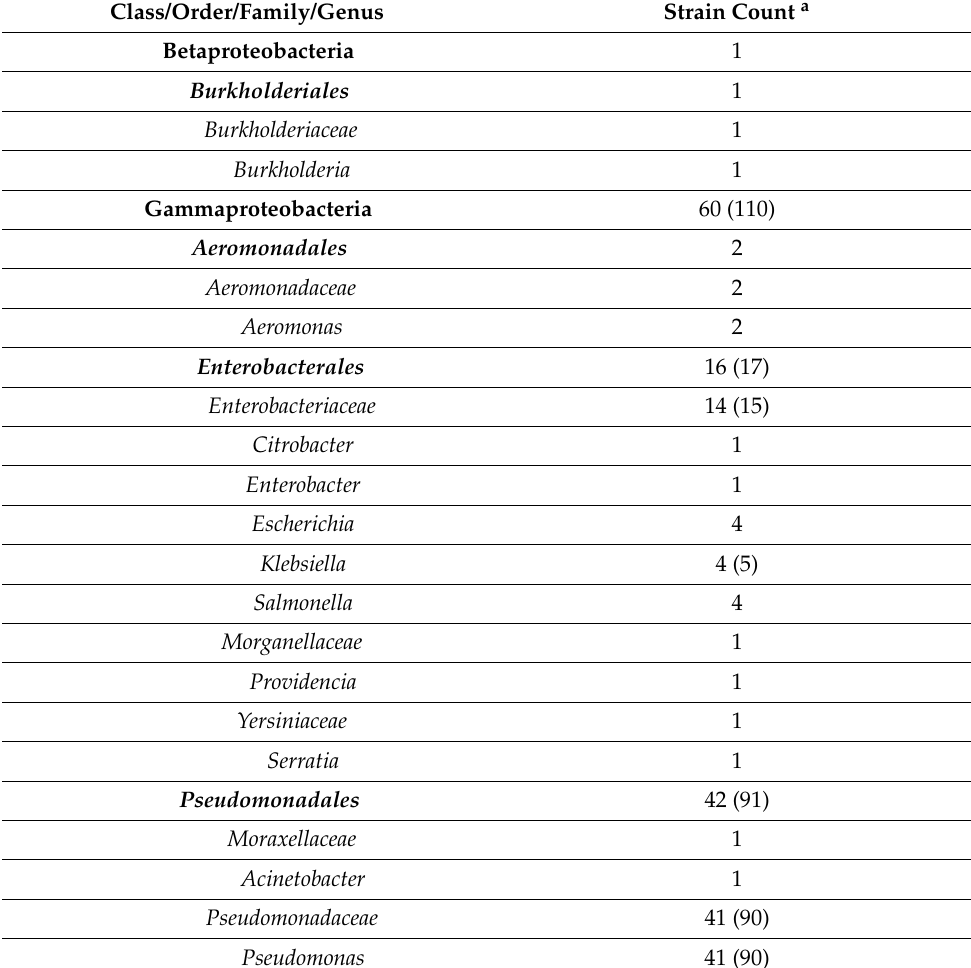
Table 2. Taxonomic classification of all strains identified that include at least one